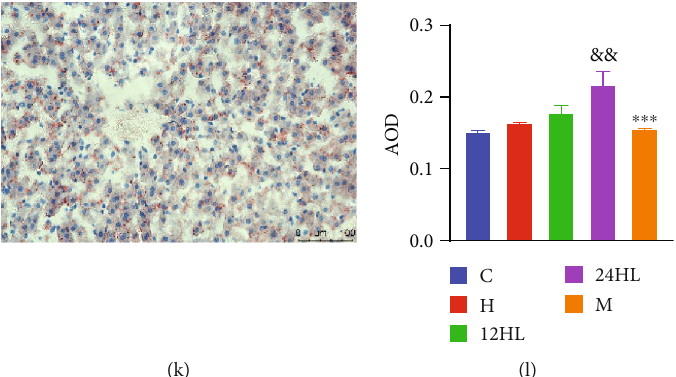
Figure 5: E ff ects of melatonin on histopathological changes in hepatic tissue. H&E staining (200x): (a) C group, (b) H group, (c) 12HL group, (d) 24HL group, and (e) M group after treatment (on week 10); (f) AOD of H&E staining. Oil Red O staining (200x): (g) C group, (h) H group, (i) 12 HL group, (j) 24HL group, and (k) M group after treatment (on week 10); (l) AOD of Oil Red O staining. Integrated optical density (IOD)/area of staining in each immunohistochemistry staining image. AOD: average optical density; C: control group; H: HFD group; 12HL: 12h light group; 24HL: 24h light group; M: melatonin group. The values are expressed as the means ± S : D : ( n = 3 per group). ### P < 0 : 001 , HFD vs. control; & P < 0 : 05 and && P < 0 : 01 , 24HL vs. 12HL group; ∗∗∗ P < 0 : 001 , M vs. 24HL